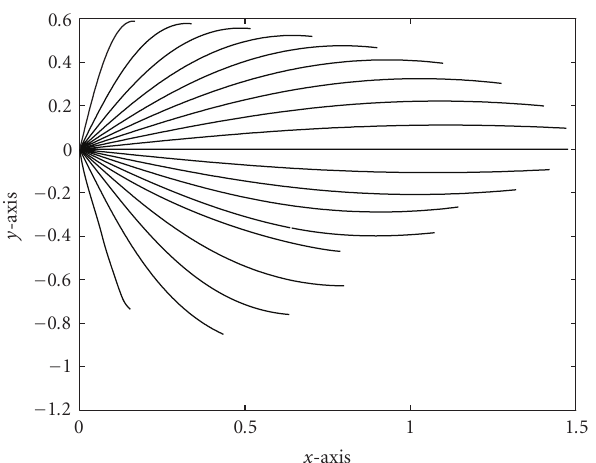
Figure 4: Intensity a z = 1mm for di ff erent asymmetry factor ( g )